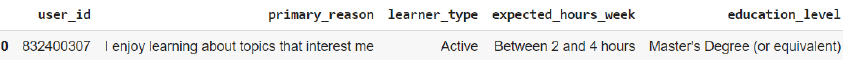
Fig. 8. Target learner for ML-based MOOC